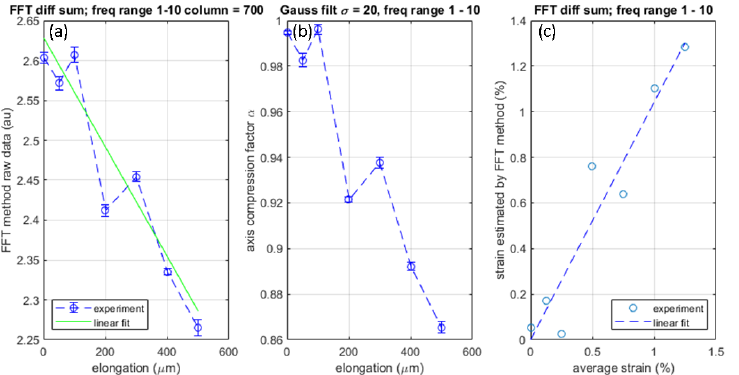
Figure 12. ( a ) Normalized Fourier spectrum vs. elongation; ( b ) Calibrated Fourier spectrum vs. elongation; ( c ) Comparison of stretching factor evaluated with frequency-domain image scaling method and average normal strain evaluated from